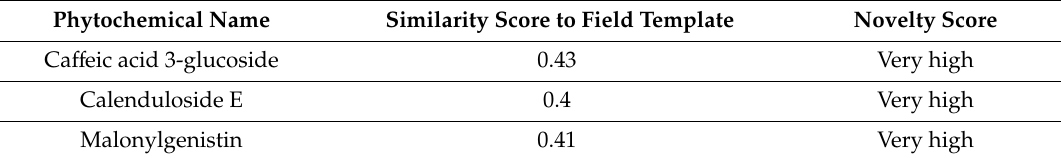
Table 1. Similarity score and novelty score of phytochemicals in garlic extract predicted by activity atlas model for DPP-4